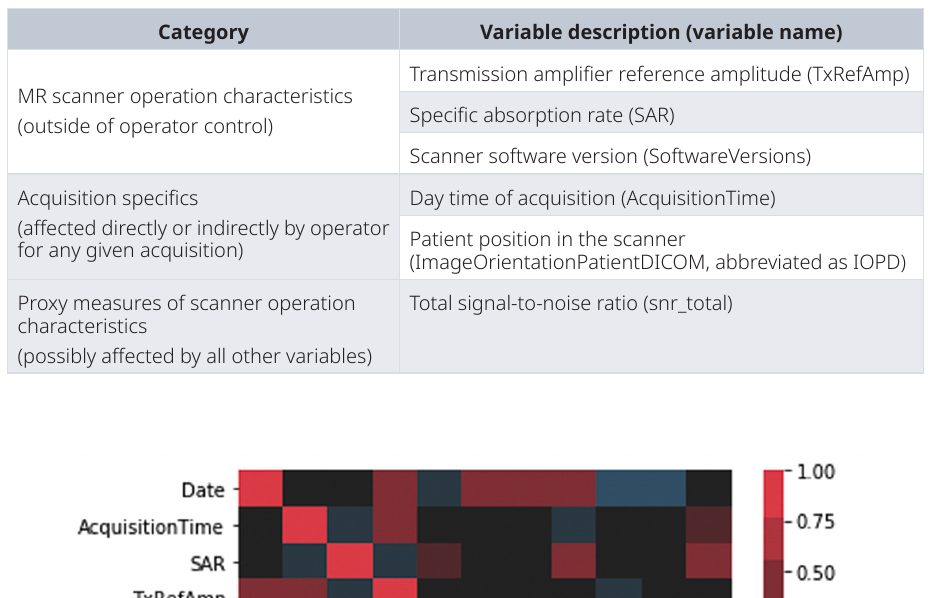
Table 1. Quality assurance metrics of interest in this study, categorically divided by interest.